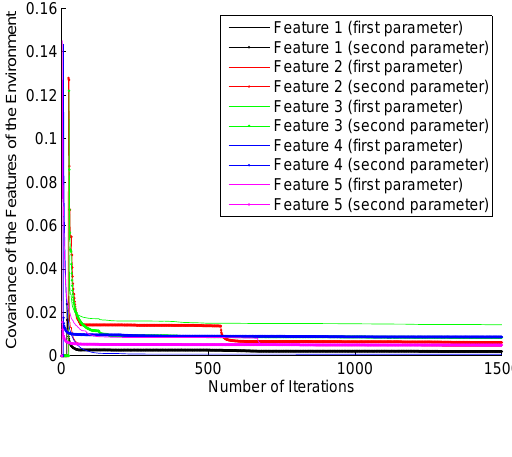
Covariance evolution of a same set of features of Figure 12 estimated by EKF-SLAM with the features’ covariance selection